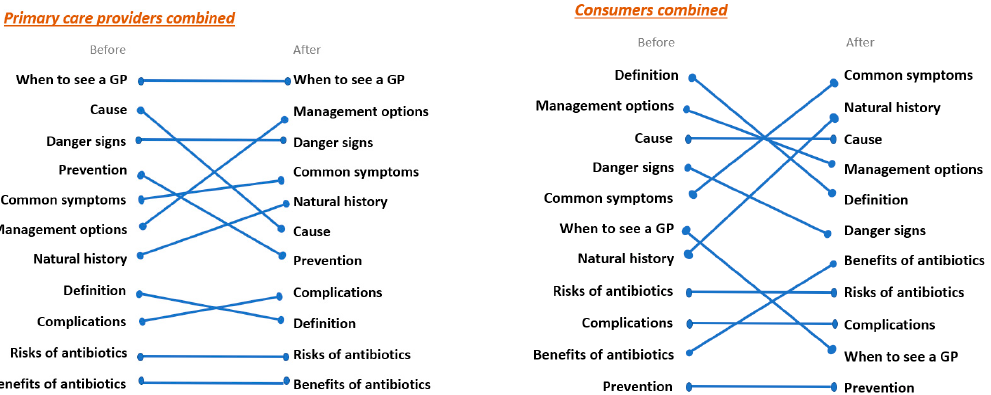
Figure 1. Ranking of 11 categories of information found in commonly used patient information sheets by primary care providers and consumers.